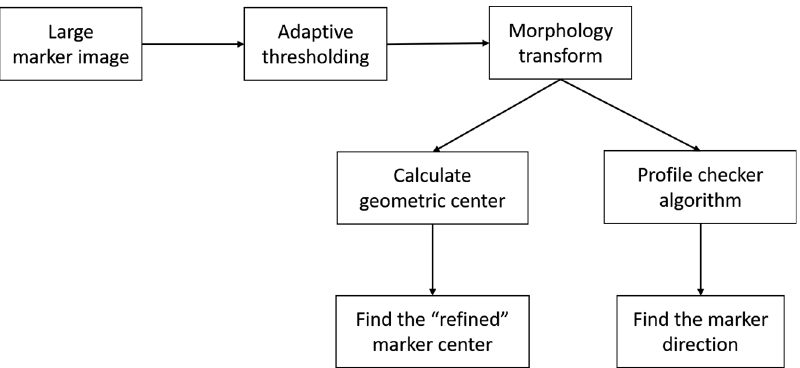
compared to the predicted lightDenseYOLO center (yellow dot), the marker center predicted by Profile Checker v2 algorithm (red dot) was much closer to the ground-truth center (green dot).